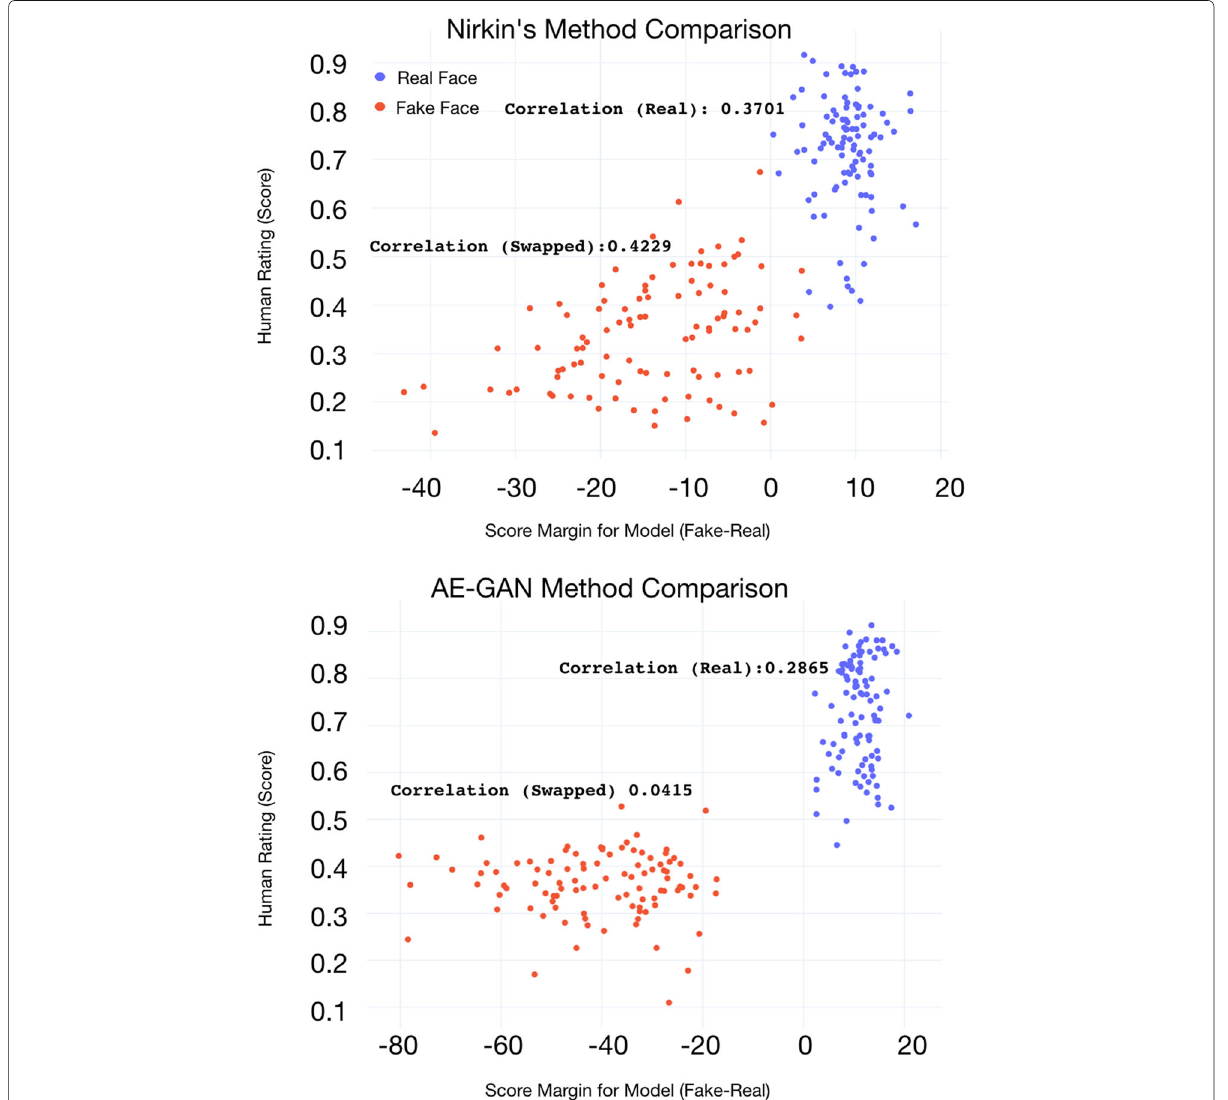
Fig. 6 Top: Nirkin’s method Pearson’s correlation for real face 0.3701 and swapped face 0.4229. Bottom: AE-GAN method Pearson’s correlation for real face 0.2865 and swapped face